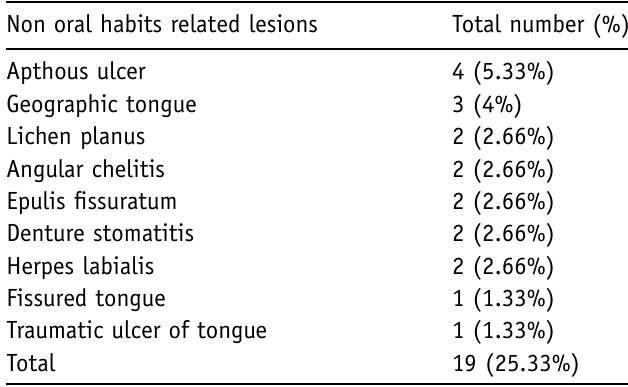
Table III. Prevalence of non oral habits related lesions in the study